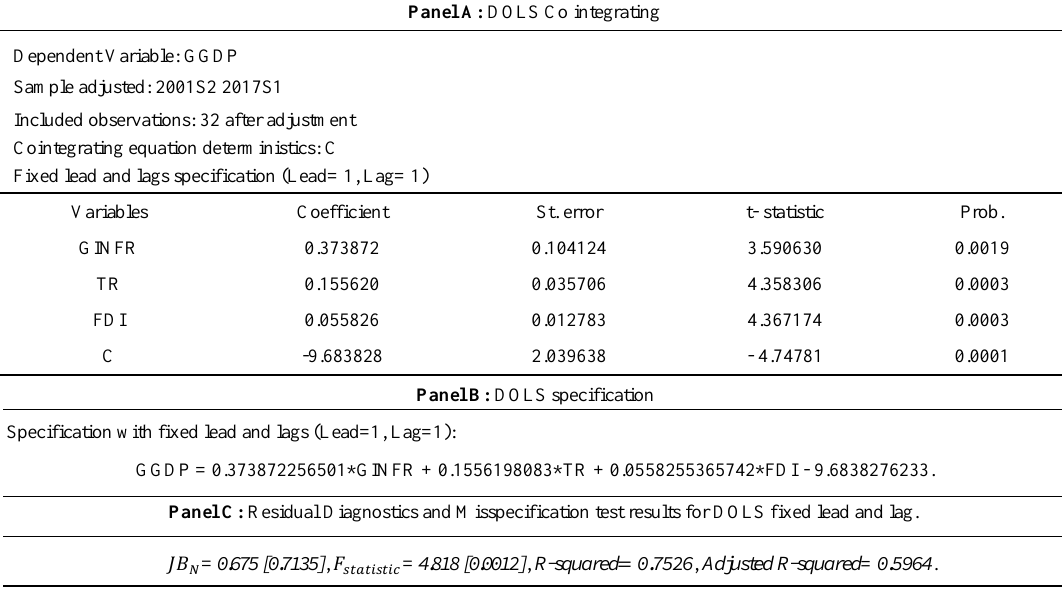
Table 3. Results in the long term.